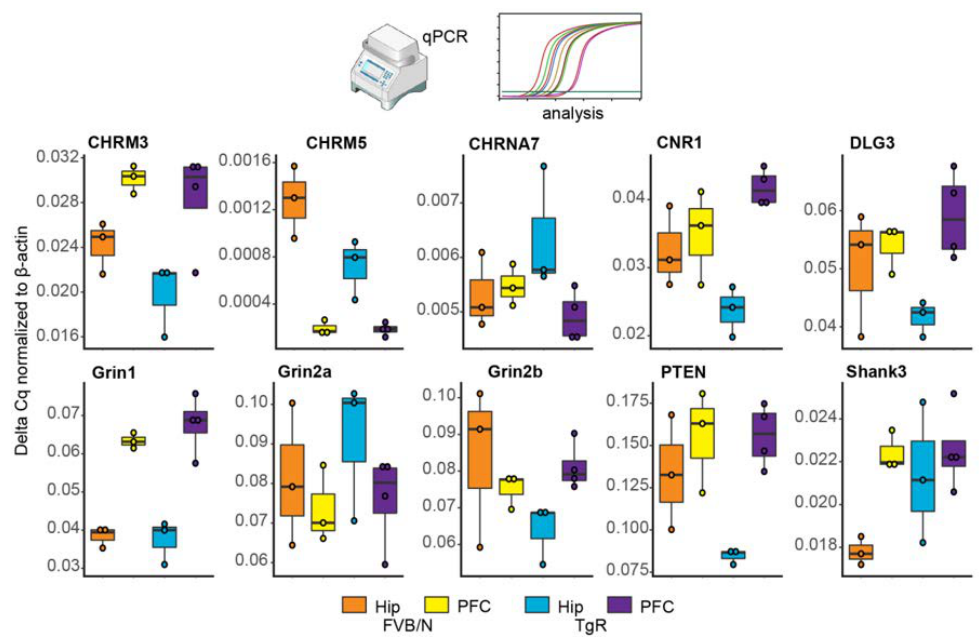
Figure 8. qPCR-validated change in cholinergic signaling related genes. Most changes between FVB / N mice and the TgR strain occur in the hippocampus. Di ff erent expression profiles can be observed between the PFC and